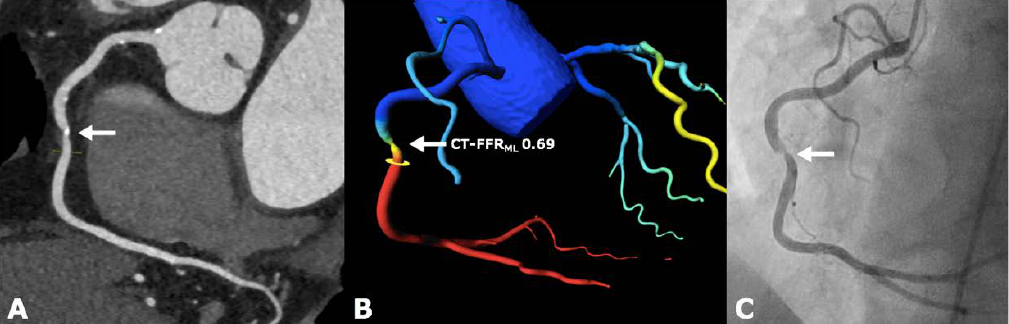
Figure 2. 66 year old female patient with suspected progress of CAD and a high cardiovascular risk profile. ( A ) Severe stenosis ( > 70% diameter stenosis) of the mid-right coronary artery (RCA) in a sectional image by cCTA (arrow). ( B ) The CT-FFR ML software (cFFR, version 3.1, Siemens Healthineers, Forchheim, Germany) illustrates a 3D-model of the mid RCA with a hemodynamically significant stenosis and a CT-FFR ML value of 0.69 (arrow). ( C ) Invasive coronary angiography shows a significant stenosis in the mid RCA (arrow).